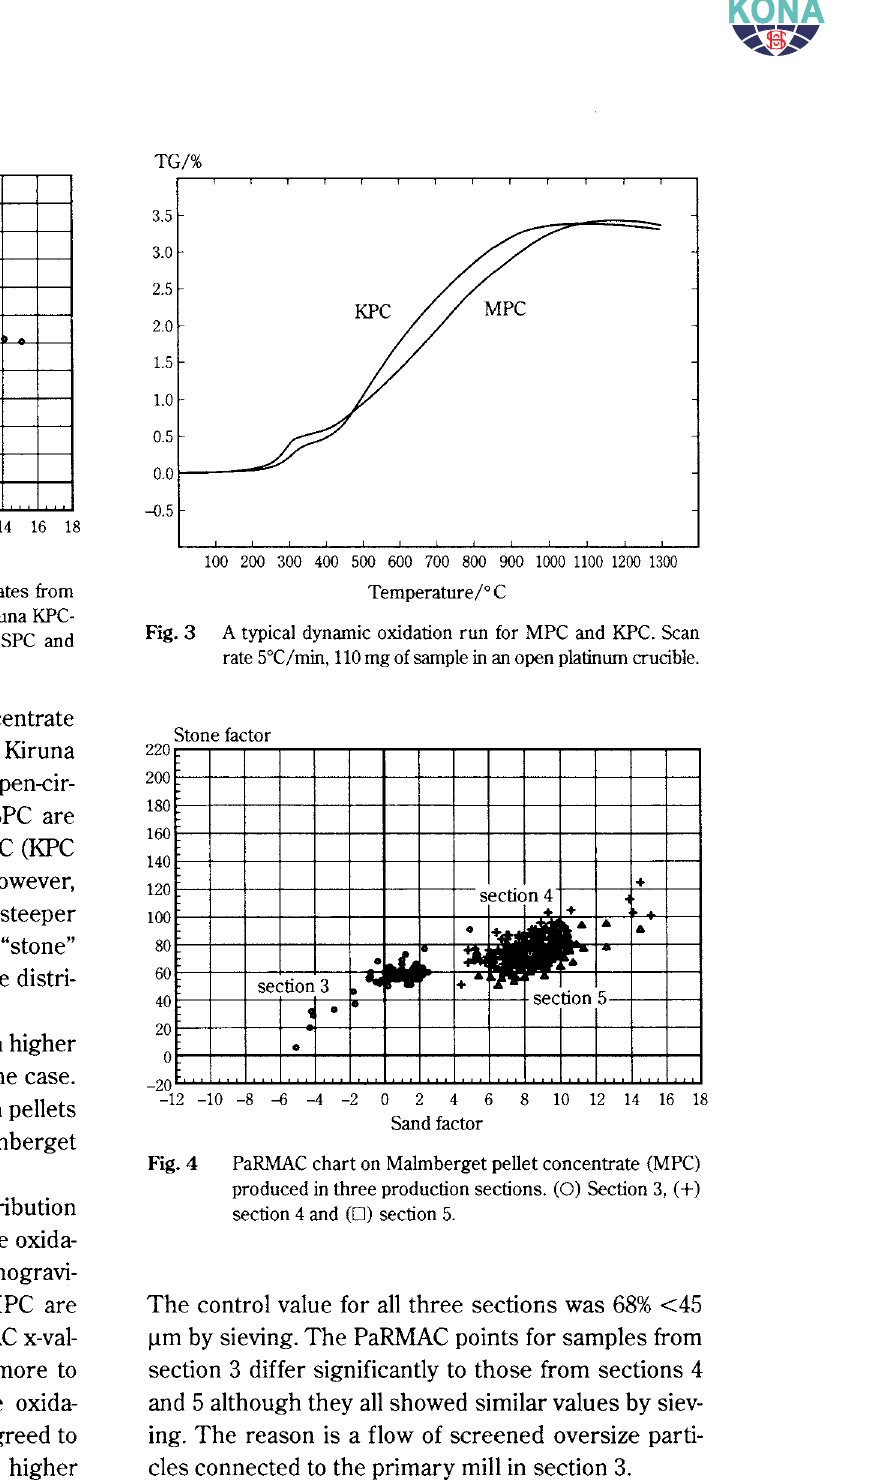
A PaRMAC chart on magnetite pellet concentrates from different concentrating plants in LKAB. (L':.) Kiruna KPC KA1, (D) Kiruna KPC-KA2, (X) Svappavaara SPC and (O) Malmberget MPC.